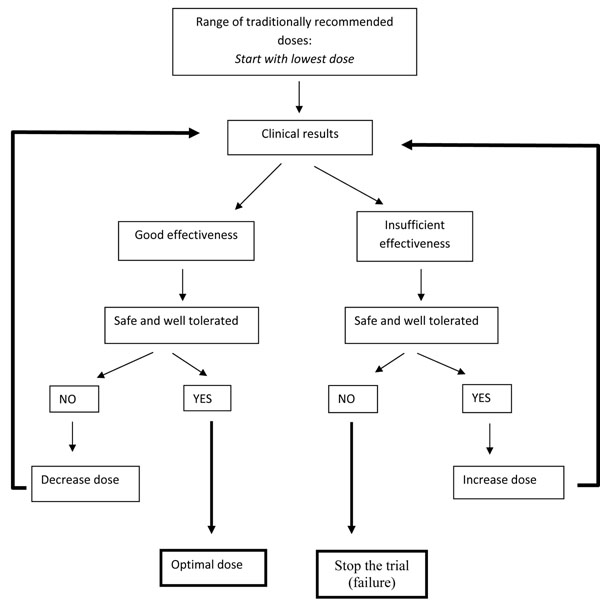
Dose optimization